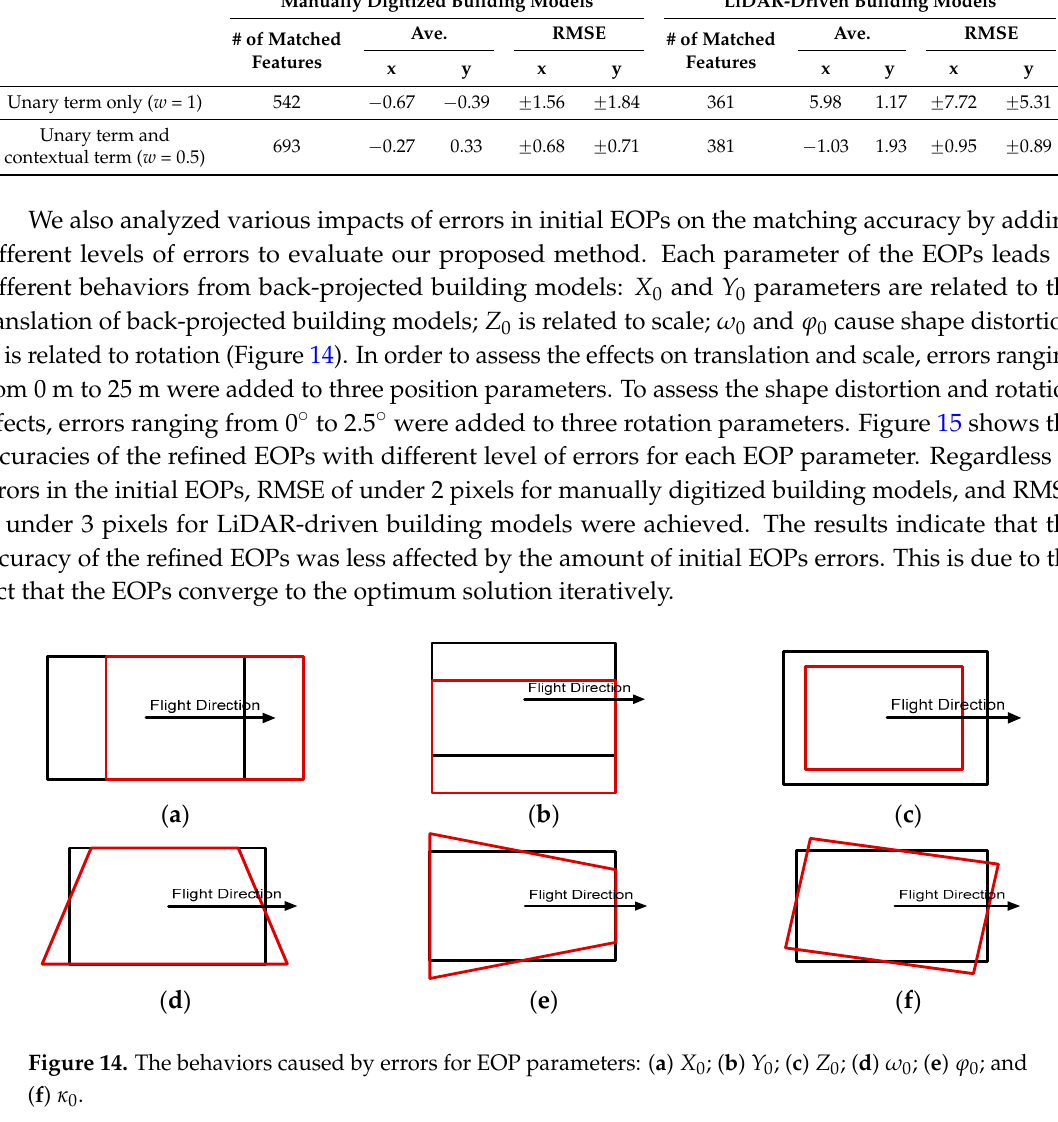
Table 6. Effect of context features (unit: pixel).